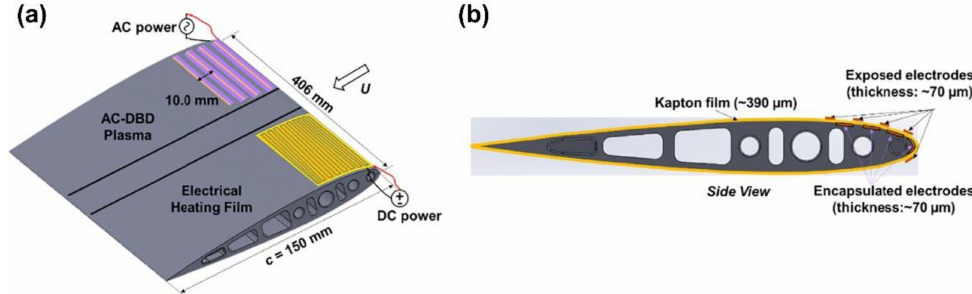
Figure 13. ( a ) Top view and ( b ) side view of NACA 0012 airfoil model with the DBD plasma actuator and electrical film heater side-by-side on the surface: ( a ) top view and ( b ) cross section view (adapted from Liu et al. [149] with the permission of